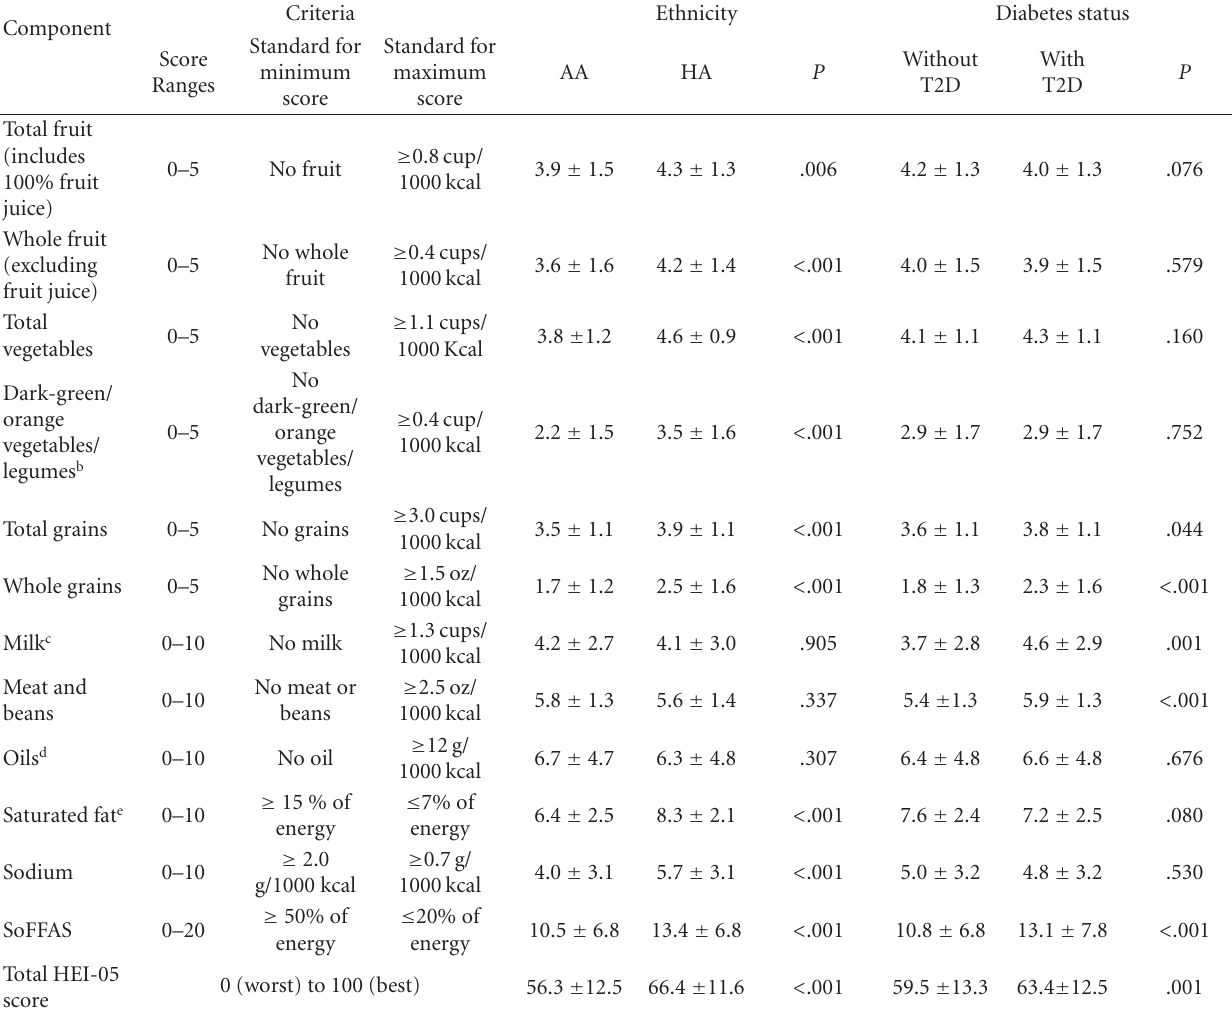
Table 2: Healthy Eating Index 2005 (HEI-05) score components and total scores a by ethnicity and diabetes